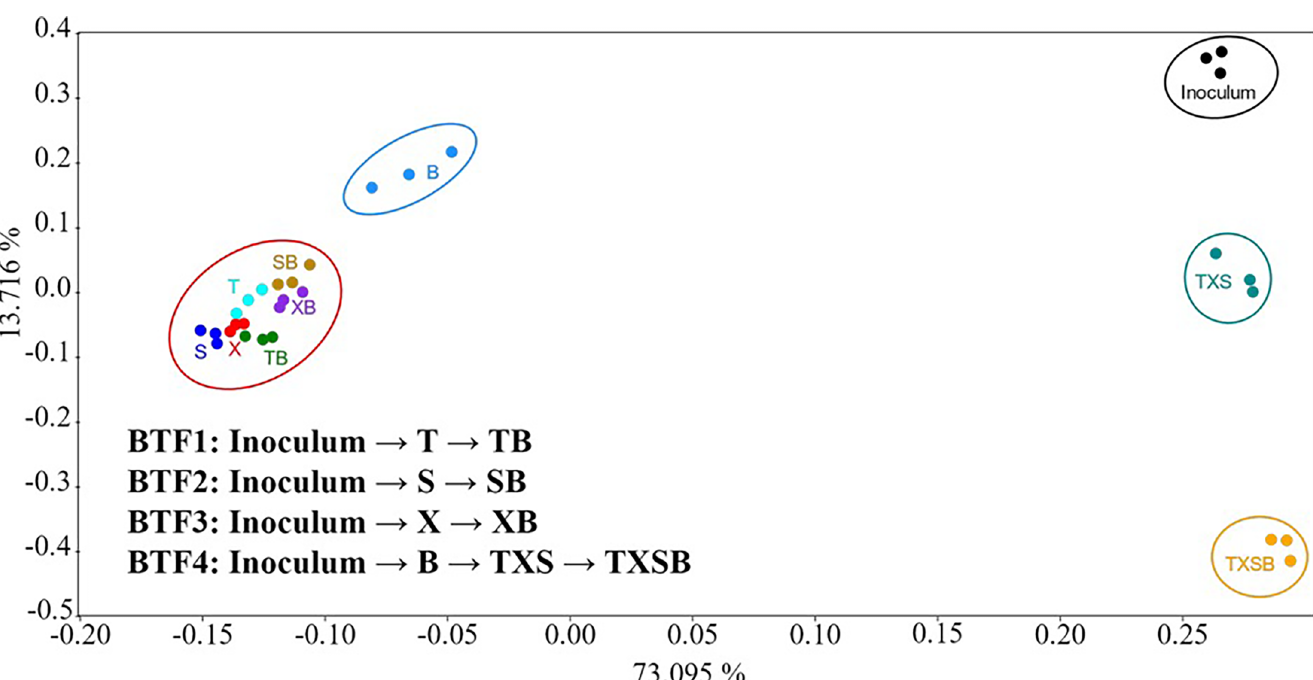
Fig 5. The plot of weighted principal coordinate analysis (PCoA) of the microbial communities based on the Bray-Curtis distance. B: benzene; T: toluene; X: xylene; S: styrene.